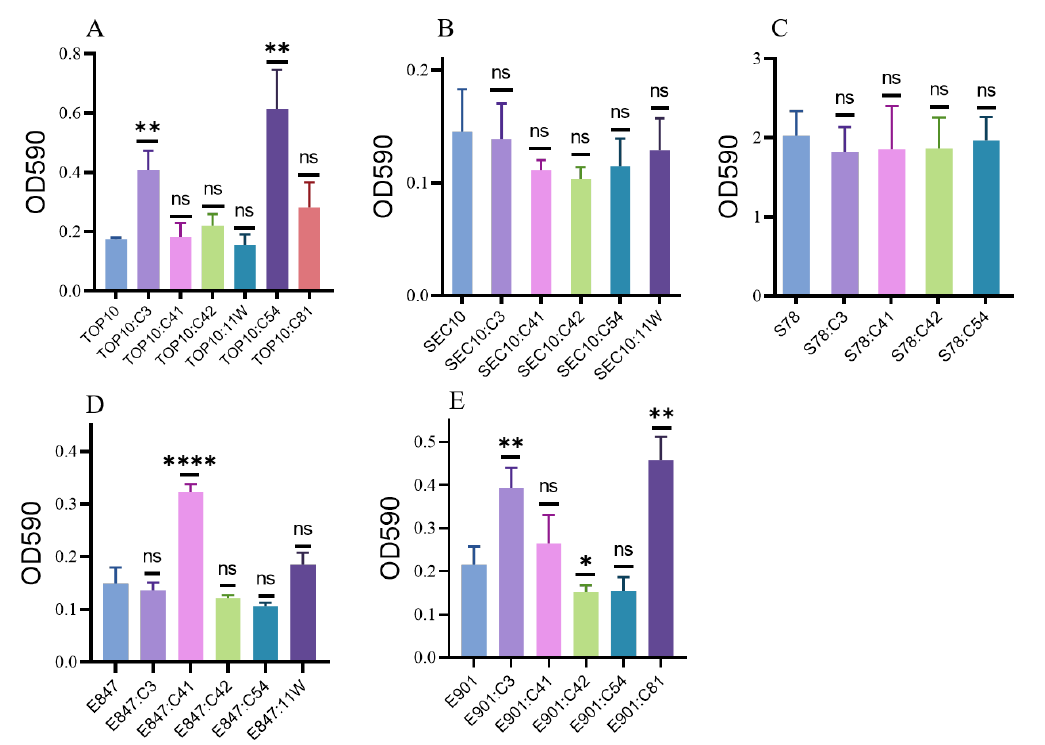
Figure 2. Biofilm formation ability of the transformants and their isogenic plasmid-free strains in this study. ( A ): Transformants of TOP10; ( B ): transformants of SEC10; ( C ): transformants of SEC78; ( D ): transformants of E847; ( E ): transformants of E901. Data are shown as mean ± SD. p -values were determined using the t -test (* p < 0.05, ** p < 0.01, **** p < 0.0001, ns, not significant).